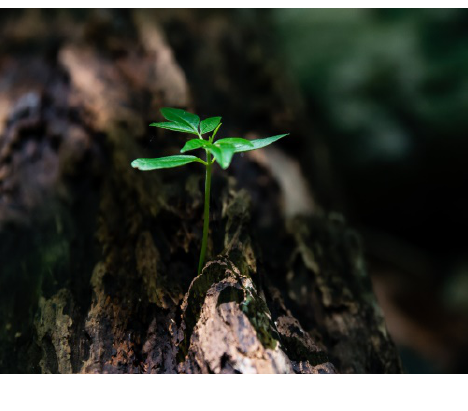
Figure 3.1 Fog Image